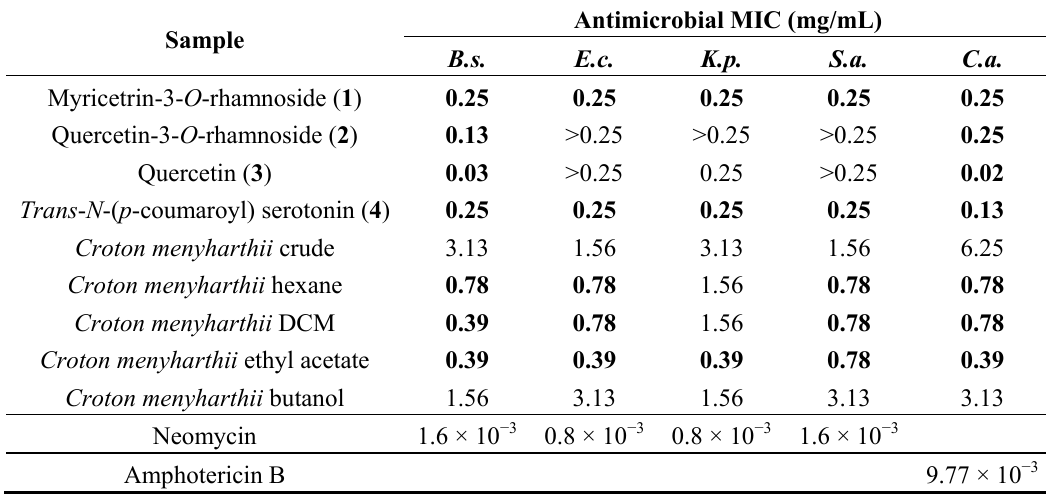
Table 1. Antimicrobial properties (MIC-mg/mL) of the isolated compounds, crude extracts and fractions from the methanol extracts of Croton menyharthii (n = 3).